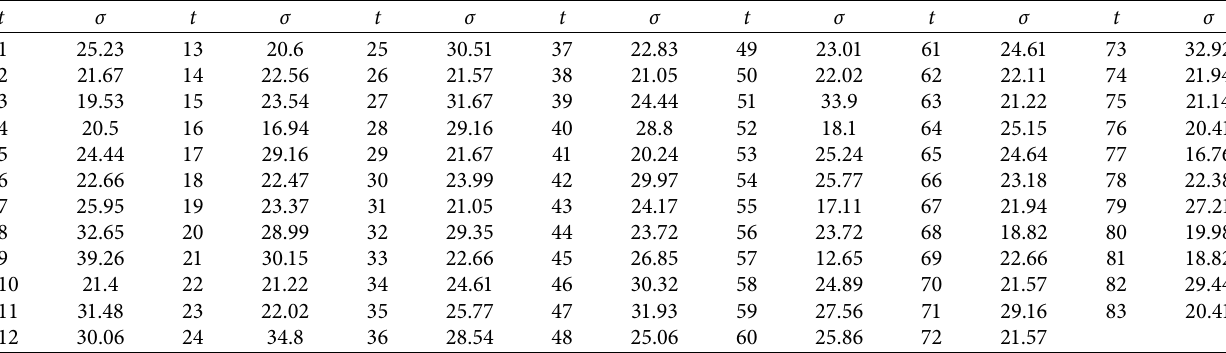
Table 1: Monitored extreme stress data for 83 days.